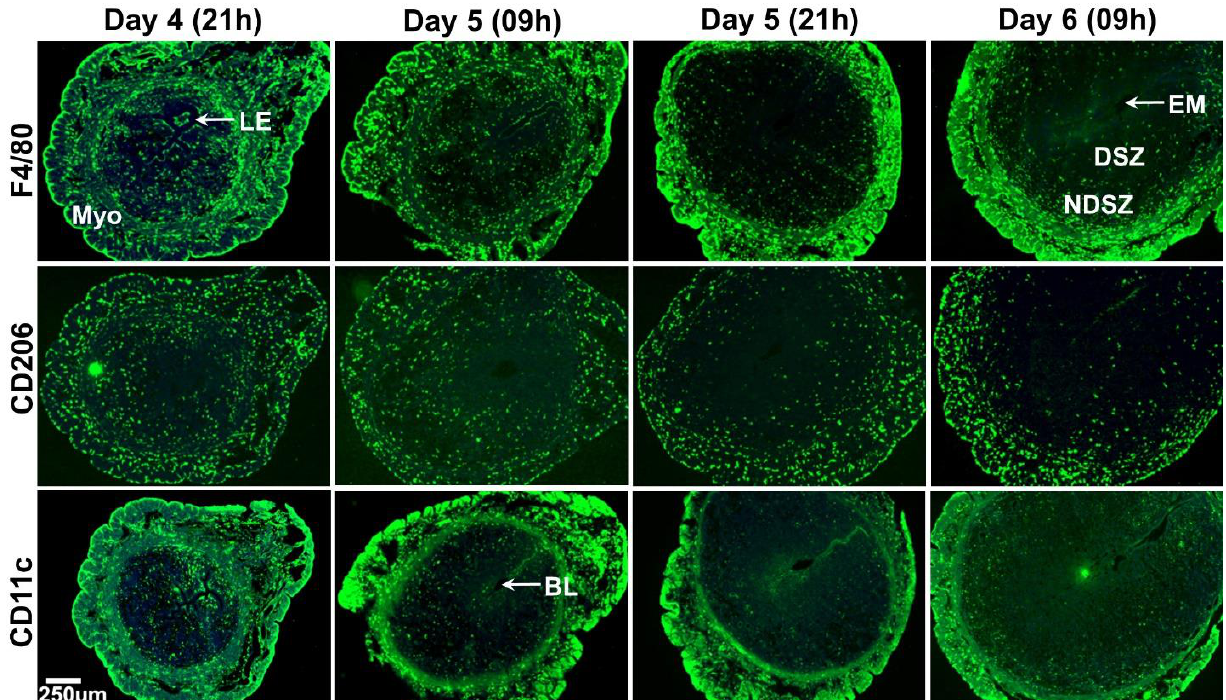
Figure 4. Event- specific change in the distribution pattern of uterine MΦs and DCs during the peri -implantation period of pregnancy. Immunofluorescence detection of F4/80, CD206 and CD11c positive cells. Cross sections obtained from two pieces of uterine tissues/mouse/timepoint of pregnancy were fixed, immunostained with F4/80, CD206 and CD11c (green), counterstained with DAPI (blue) and photographed. At least three pregnant mice were used at each timepoint of pregnancy. BL, blastocyst; DSZ, decidualized stromal zone; EM, embryo; LE, luminal epithelium; Myo, myometrium; NDSZ, non-decidualized stromal zone.